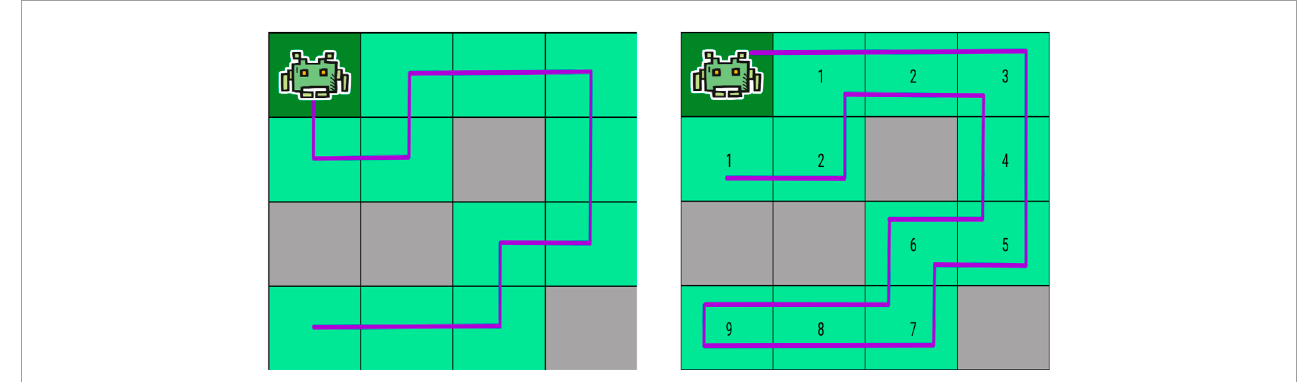
FIGURE 3 Difference in the path obtained by an optimal solver (left) and by the wavefront algorithm (right). For the wavefront algorithm, the wave values are shown inside each grid cells.